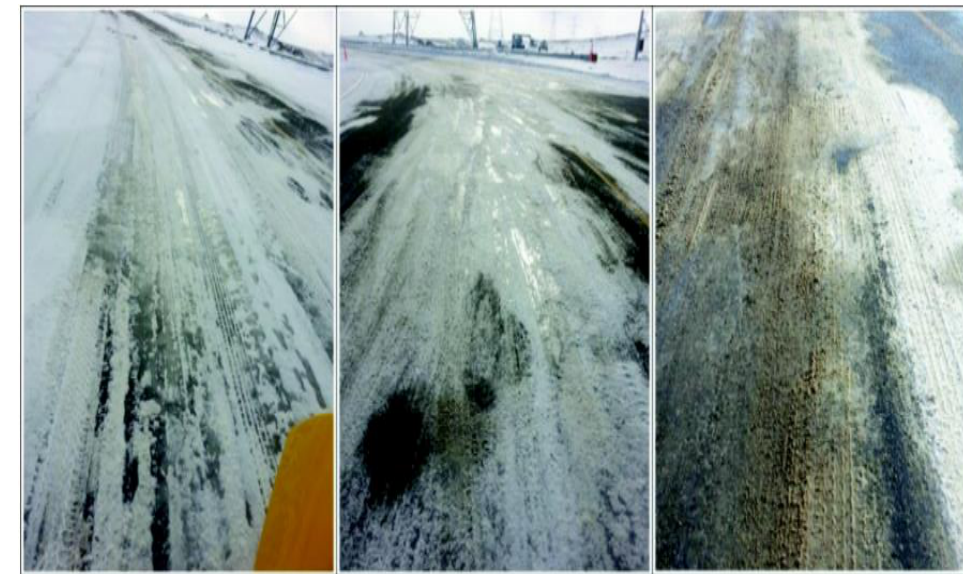
Figure 7. Sand applied on icy road surface at the IRRF test road in Canada [58].